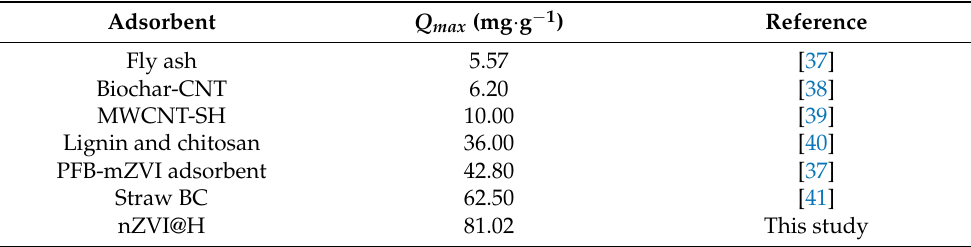
Table 5. Comparison of adsorption capacity of MB on diversified adsorbents.